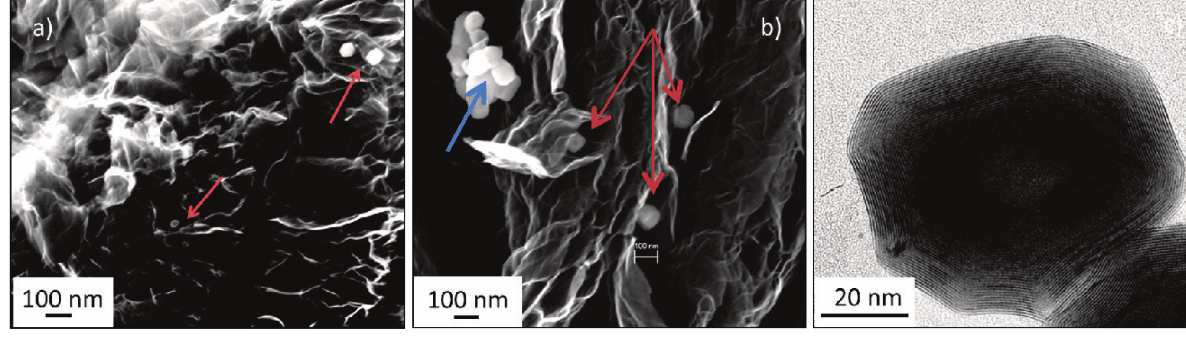
hybrids and IF-WS . Scanning 2 2 hybrid generated from GO and WO ; 2 3 ; and ( c ) Transmission 3